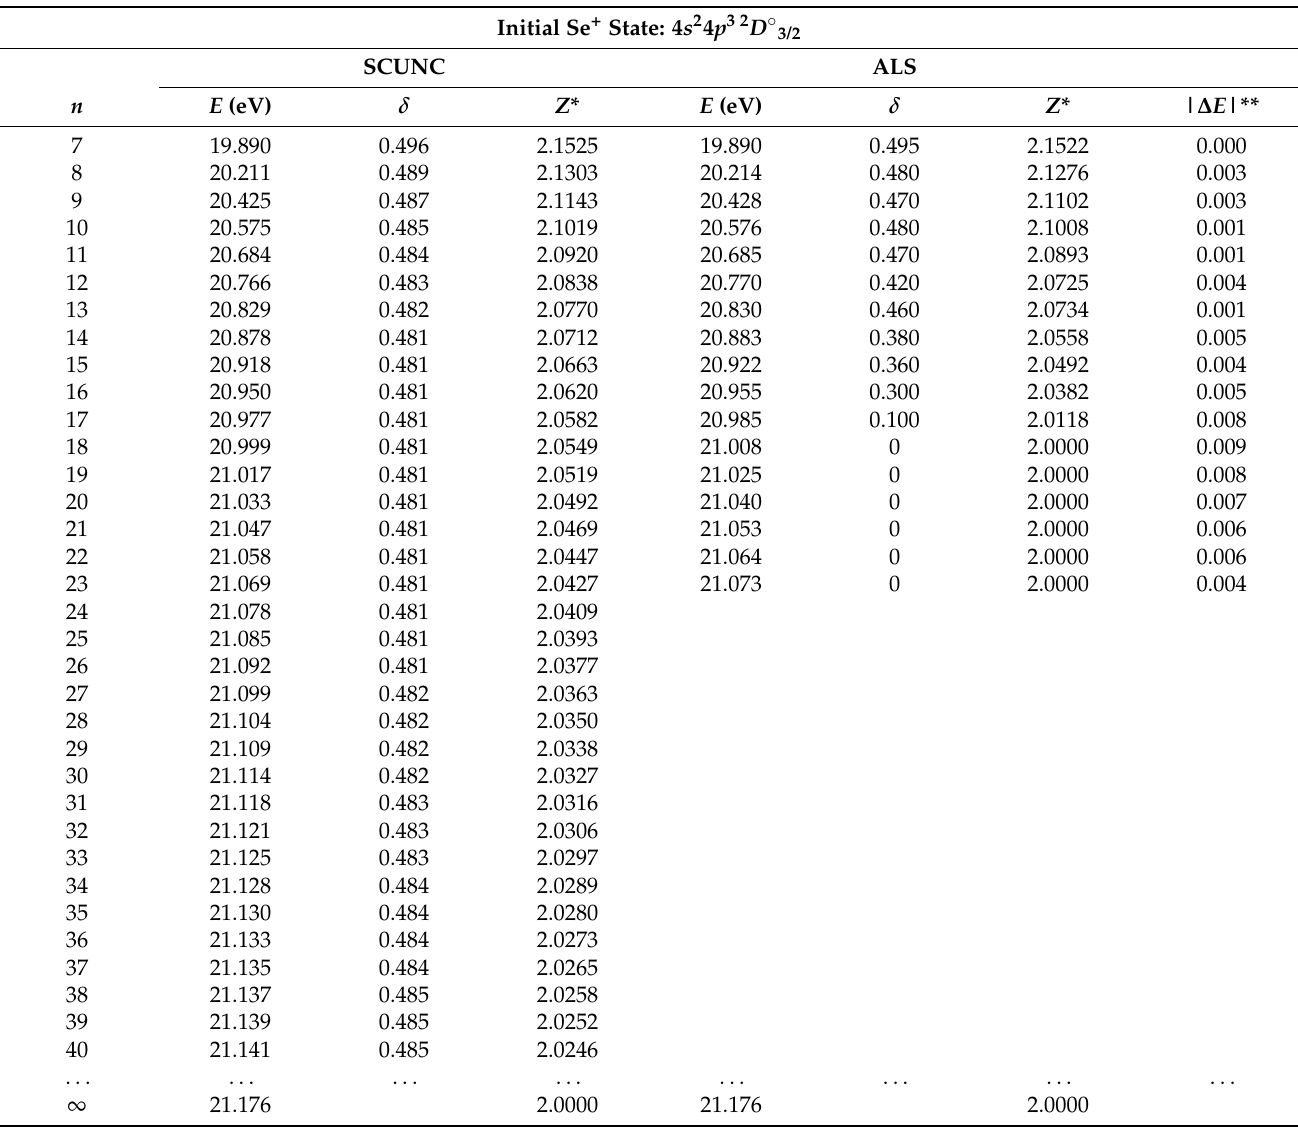
Table 11. Energy resonances ( E ), quantum defect ( δ ) and effective charge ( Z *) of the 4 s 2 4 p 2 ( 1 D 2 ) ns ( 2 D ) Rydberg series originating from the 4 s 2 4 p 3 2 D ◦ 3/2 metastable state of Se + converging to the 1 D 2 series limit in Se 2+ . The present results (SCUNC) are compared with the experimental data from ALS measurements [6]. f 1 ( 1 D 2 ; 2 D ◦ 3/2 ) = − 0.912 ± 0.050 with ν =